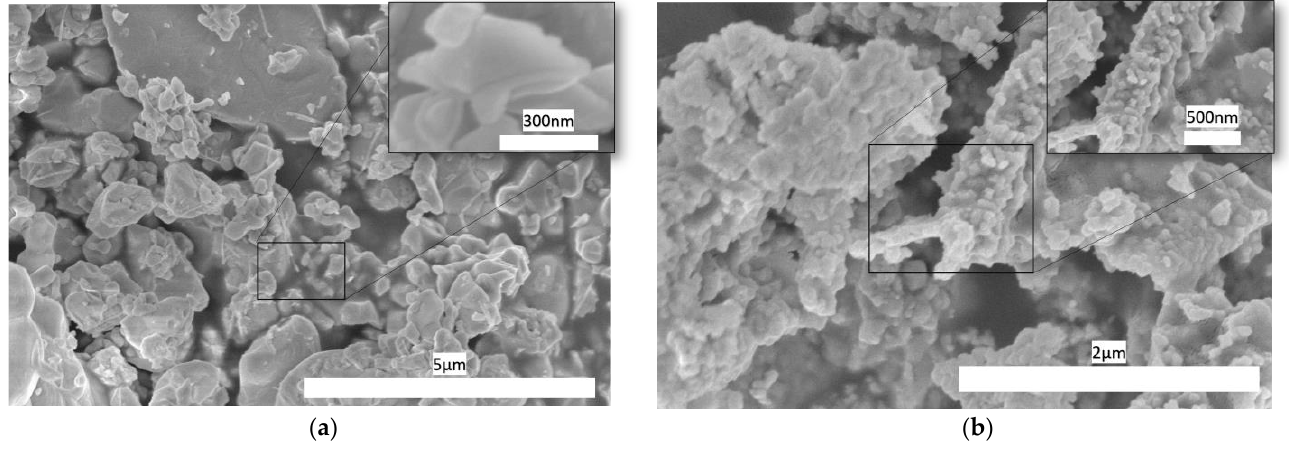
Figure 3. SEM images of ( a ) BFO flakes and ( b ) BSFO nanoparticles. According to the elemental analysis, the atomic ratio of metals Bi: Fe in the original material is 4:1 which is quite far from the expected stoichiometry of BFO, indicating